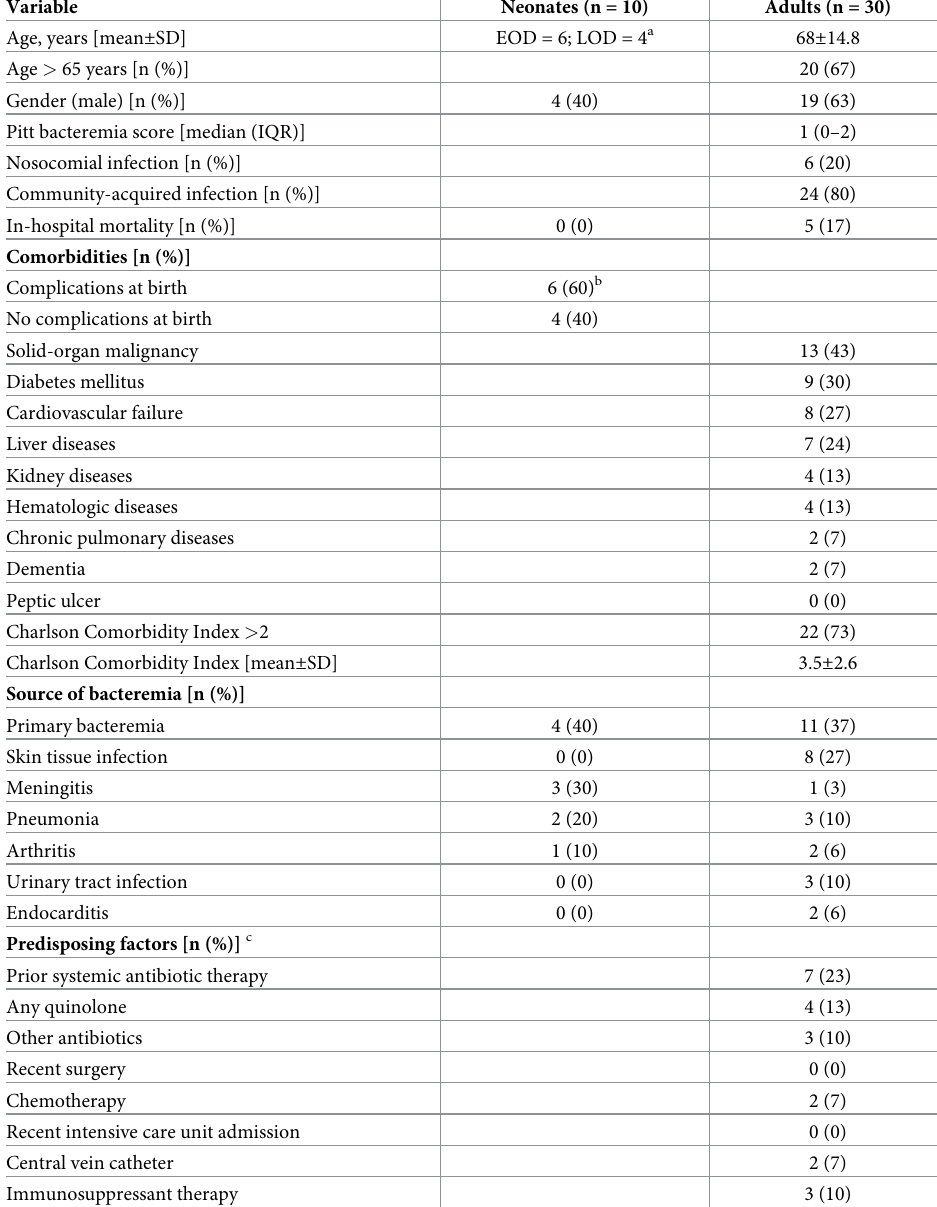
Table 2. Clinical presentations of the 40 GBS isolates used in the